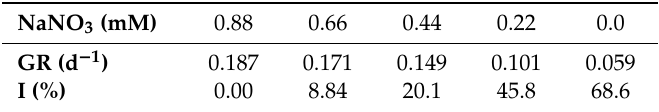
Table 1. The impact of nitrogen concentration on the growth rate (GR) and the level of growth rate inhibition (I) in Tisochrysis lutea